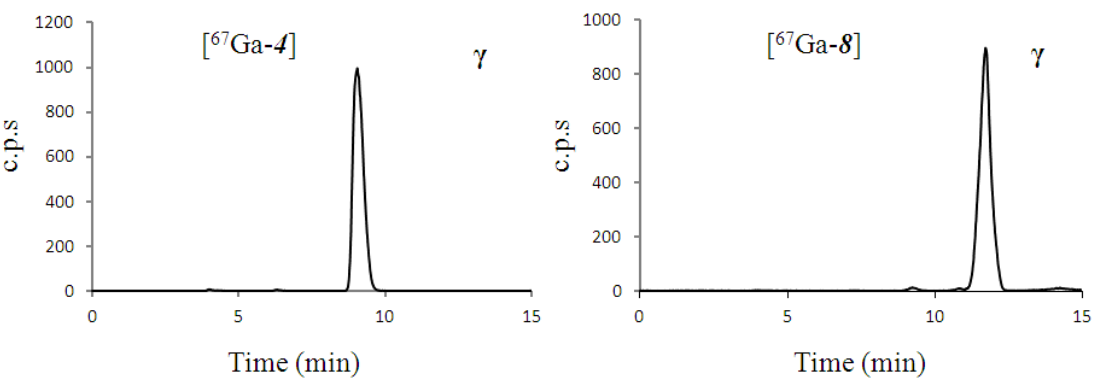
Figure 1. Analytical radio-trace chromatograms of complexes [ 67 Ga- 4 ] and [ 67 Ga- 8 ] produced in high yield from >200 MBq of 67 GaCl